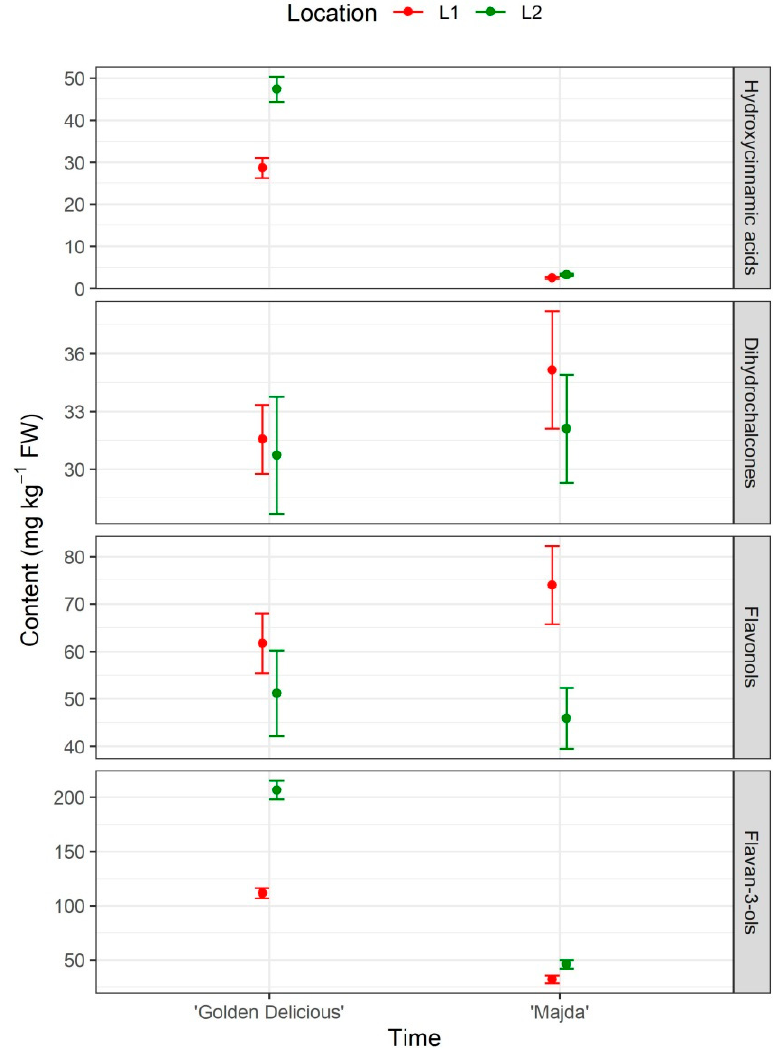
Figure 7. Phenolic content in apple peel presented in four groups: Hydroxycinnamic acids, dihy- drochalcones, flavonols, and flavan-3-ols (mg kg − 1 FW; mean ± SE) for cultivars ‘Golden Delicious’ and ‘Majda’ at two different locations (L1 and L2).